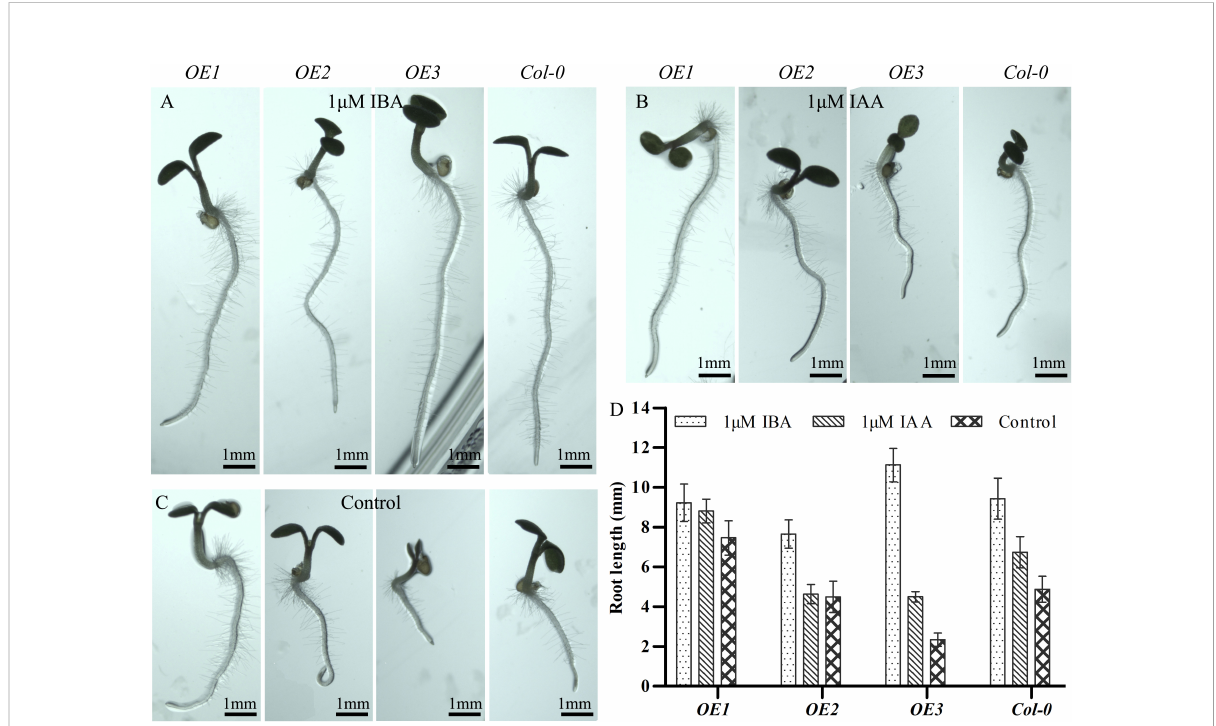
FIGURE 5 Response to exogenous auxin in transgenic Arabidopsis overexpressing MsARF5 . (A – C) . Impact of exogenous IBA (A) and IAA (B) on transgenic seedlings overexpressing MsARFs compared to controls (C) . (D) Quantitative analysis on root length following exposure to IBA/IAA. The letters in the fi gure are the results of Duncan ’ s multiple comparisons. The same letter in each column indicates that the difference is not signi fi cant, and different letters indicate that the difference is signi fi cant P =